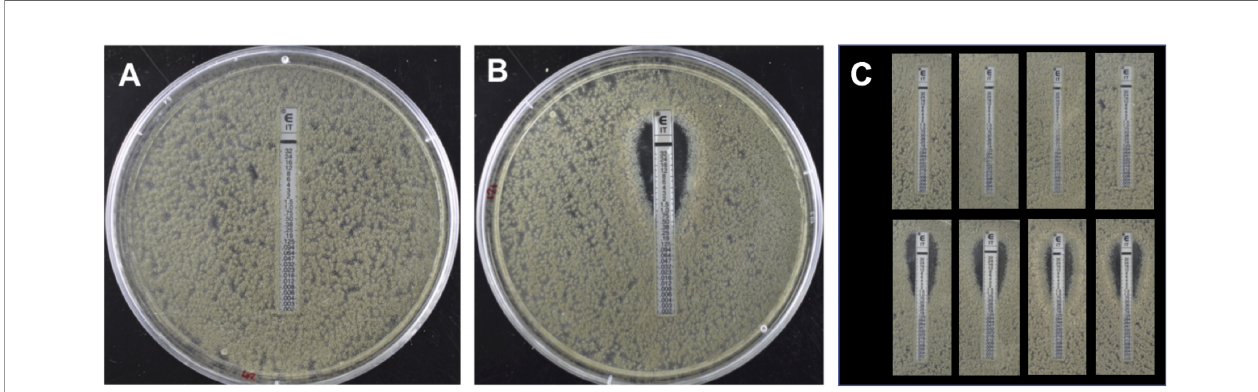
FIGURE 1 | Itraconazole ETEST sensitivity testing of Aspergillus fumigatus strains 47-308 (A) and 47-51 (B) and progeny from back crossing. The ETEST has a concentration of 32 mg L -1 itraconazole at the top of the strip which decreases down the strip towards the bottom. (A) Isolate 47-308 shows full growth over the range of itraconzole concentrations, indicating a resistance MIC of >32 mg L -1 . (B) Isolate 47-51 shows inhibition of growth at itraconazole concentrations above 0.75 mg L -1 indicating a sensitive phenotype. (C) Representative ETEST results of progeny isolated from the third backcross between a resistant progeny isolate and the itraconazole sensitive parental isolate 47-51. Results demonstrate a 1:1 segregation of the resistant (top row) and sensitive (bottom row)